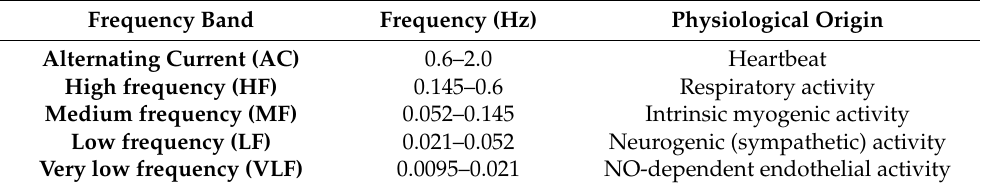
Table 1. Frequency intervals and their attributed physiological origin [14]. NO: Nitric